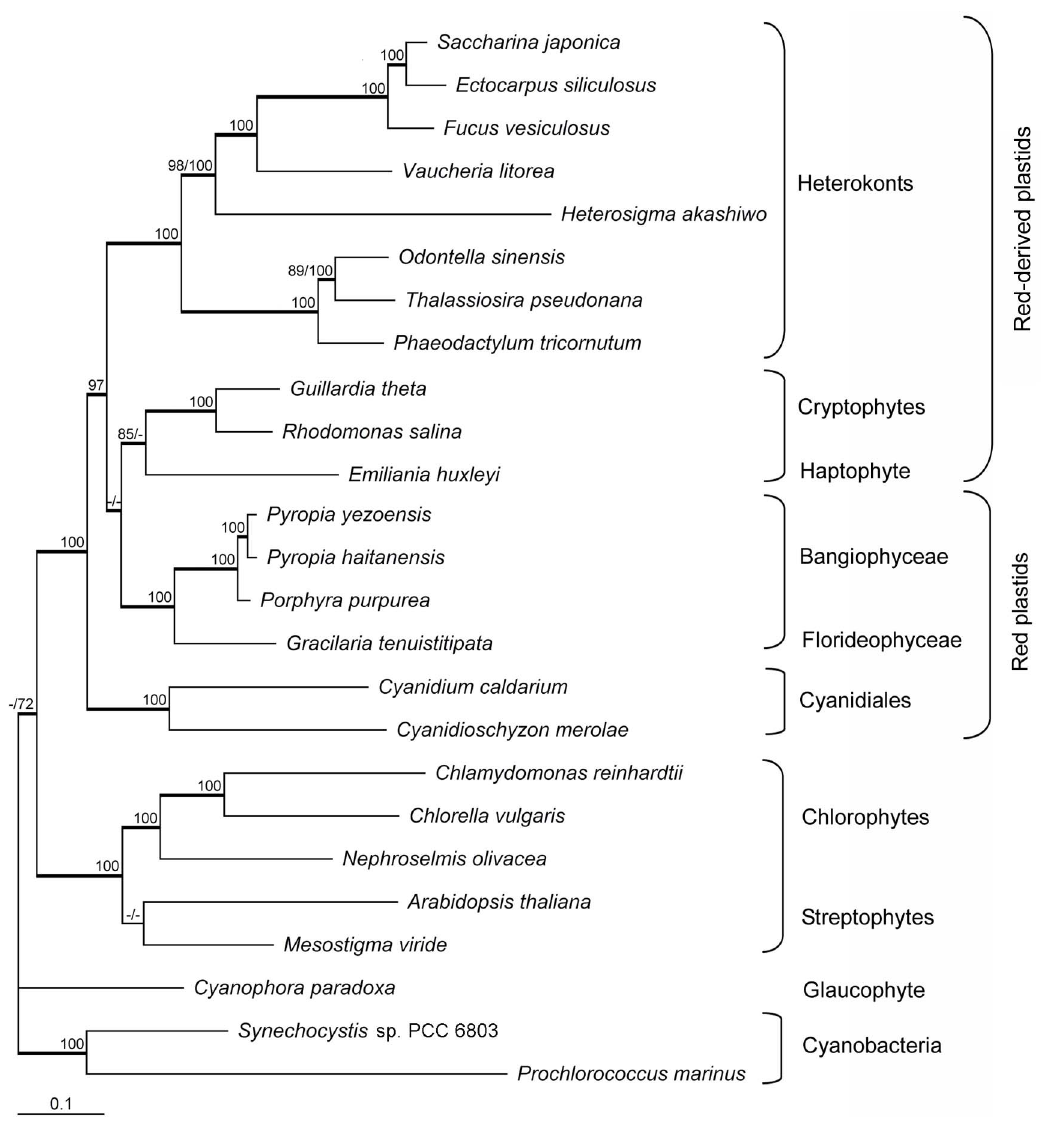
Figure 4. Maximum likelihood tree based on 44 concatenated proteins from 25 complete plastid or cyanobacterial genomes. ML and Neighbor Joining trees were constructed based on 8,628 amino-acid sites using cpREV and JTT matrices, respectively. When above 65% and different, bootstrap values (1000 replicates) are provided for ML (first value) and NJ (second value) analyses. The thick branches represent $ 0.9 posterior probability for Bayesian inference